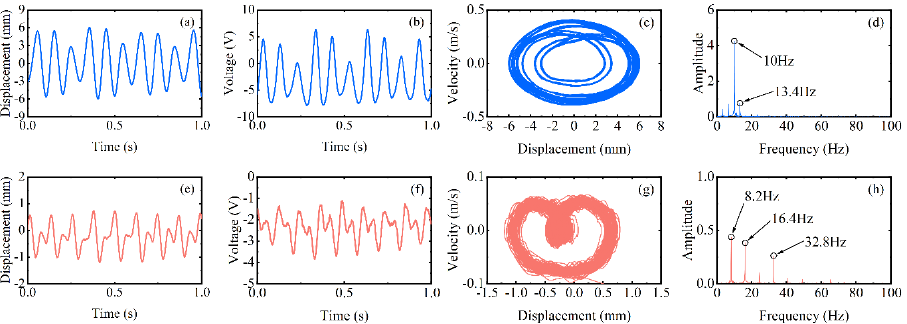
Figure 5. Experimental results of the inverse beam at 90 rpm (blue line) and 200 rpm (red line), ( a , e ) are the corresponding measured displacements, (( a1 , a2 ) are enlarged view of the red square in ( a )), ( b , f ) are the corresponding measured output voltages, ( c , g ) are the displacement-velocity phase portrait, and ( d , h ) are the corresponding power spectrums.